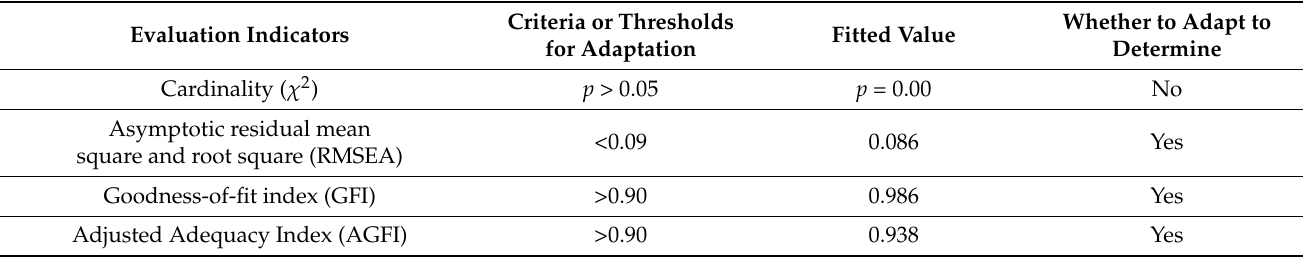
Table 8. Path analysis model fit indices of the reform of property rights of farmland water facilities affecting irrigation